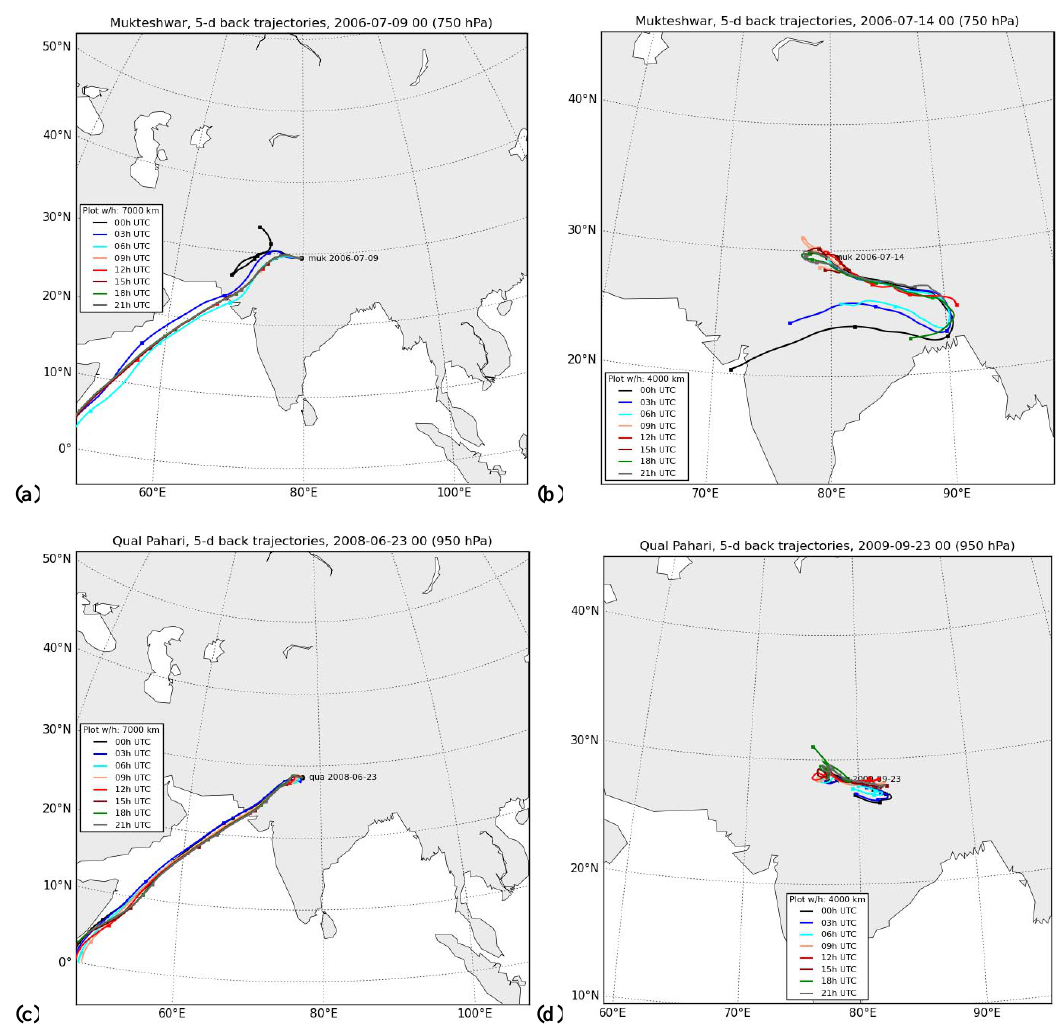
Fig. 12. 5-day calculated backtrack trajectories from example high concentration episodes during monsoon in Gual Pahari and Mukteshwar. (a, c) Mineral dust from the Thar desert. (b) Mineral dust from the Himalayan region. (d) Anthropogenic emissions from local sources and New